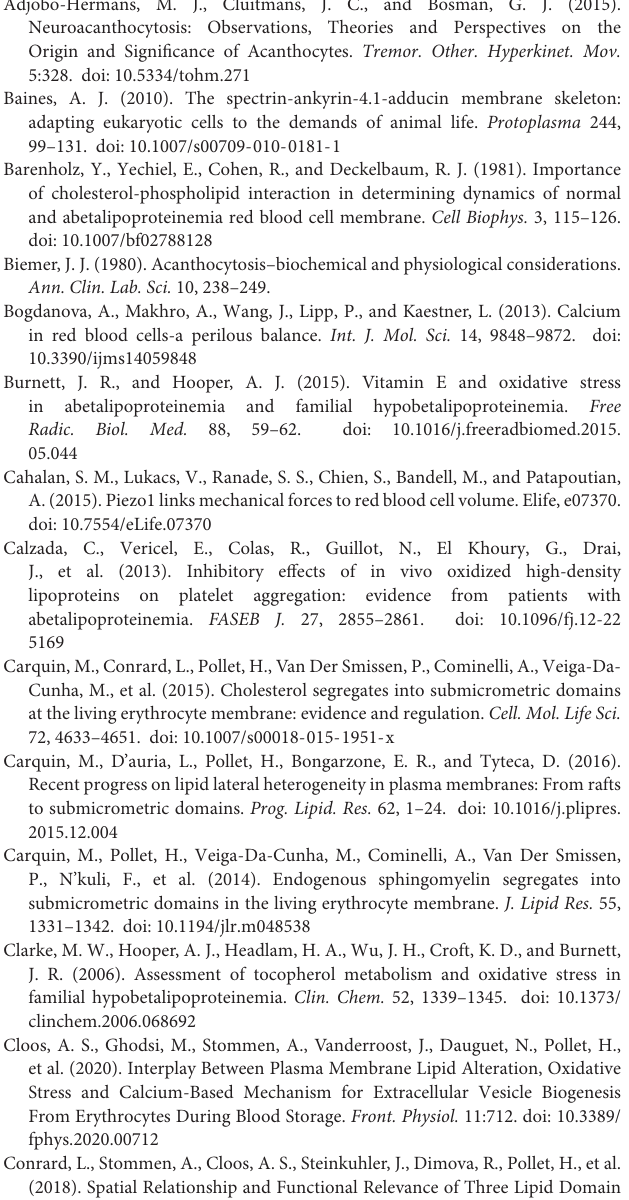
(E) Lipid domain abundance determined as in Figure 8B . Data are means ± SEM of 4–5 independent experiments. Kruskal–Wallis test followed by Dunn’s comparison test. Ns, not significant. (F) Proportion of RBCs with cer-enriched patches and vesicles determined as in Figure 9C . Upper panel, representative image of RBCs from the splenectomised donor; lower panel, quantification of cer-enriched patches (red arrowheads) and vesicles (red arrows) in RBCs from non-splenectomised (black columns) and splenectomised (gray columns) donors. Data are means ± SEM of 3–6 independent experiments. Mann–Whitney tests to compare non-splenectomised vs. splenectomised RBCs; ns, not significant; ∗ p < 0.05. (G) MitoTracker labeling as in Figure 10G . Upper panels, transmission; lower panels, transmission combined with fluorescence. MitoTracker-positive vesicles are indicated with red arrows. Images are representative of 3 experiments.